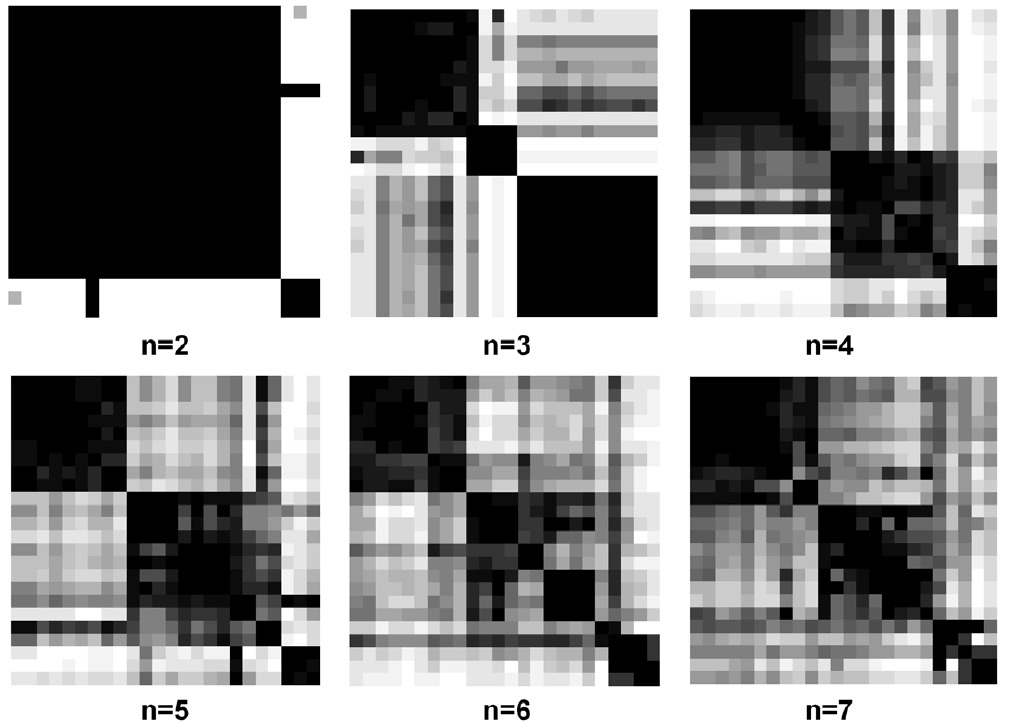
Figure 2. The consensus matrices for different numbers of clusters n based on morphological representations are shown. A darker block indicates higher morphological similarity between two cell lines. One can hypothesize that the larger block for n ~ 2 has been partitioned into two blocks for n ~ 3 ; however, the order is not preserved.